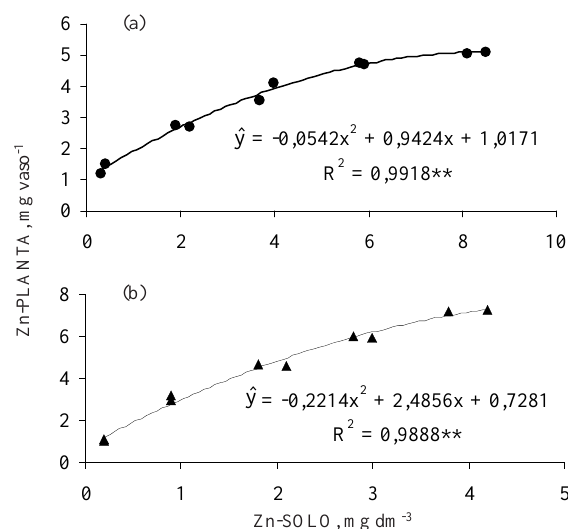
Figura 1. Relação entre teor de zinco extraído por DTPA e na parte aérea da planta em amostras coletadas: (a) antes do plantio (solo) e depois do 1 o corte (planta) e (b) depois do 3 o corte (solo e planta), em dois níveis de calagem.